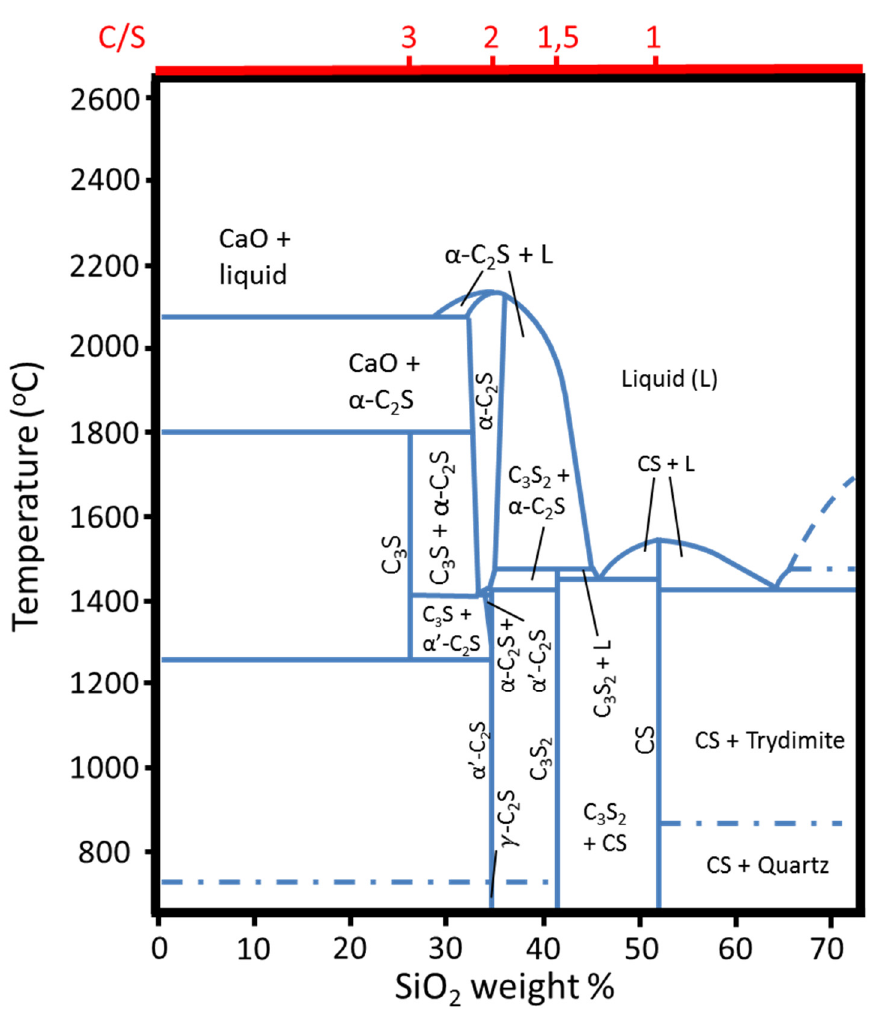
Figure 1. Detail of the CaO-SiO 2 equilibrium phase diagram (adapted from [25]).